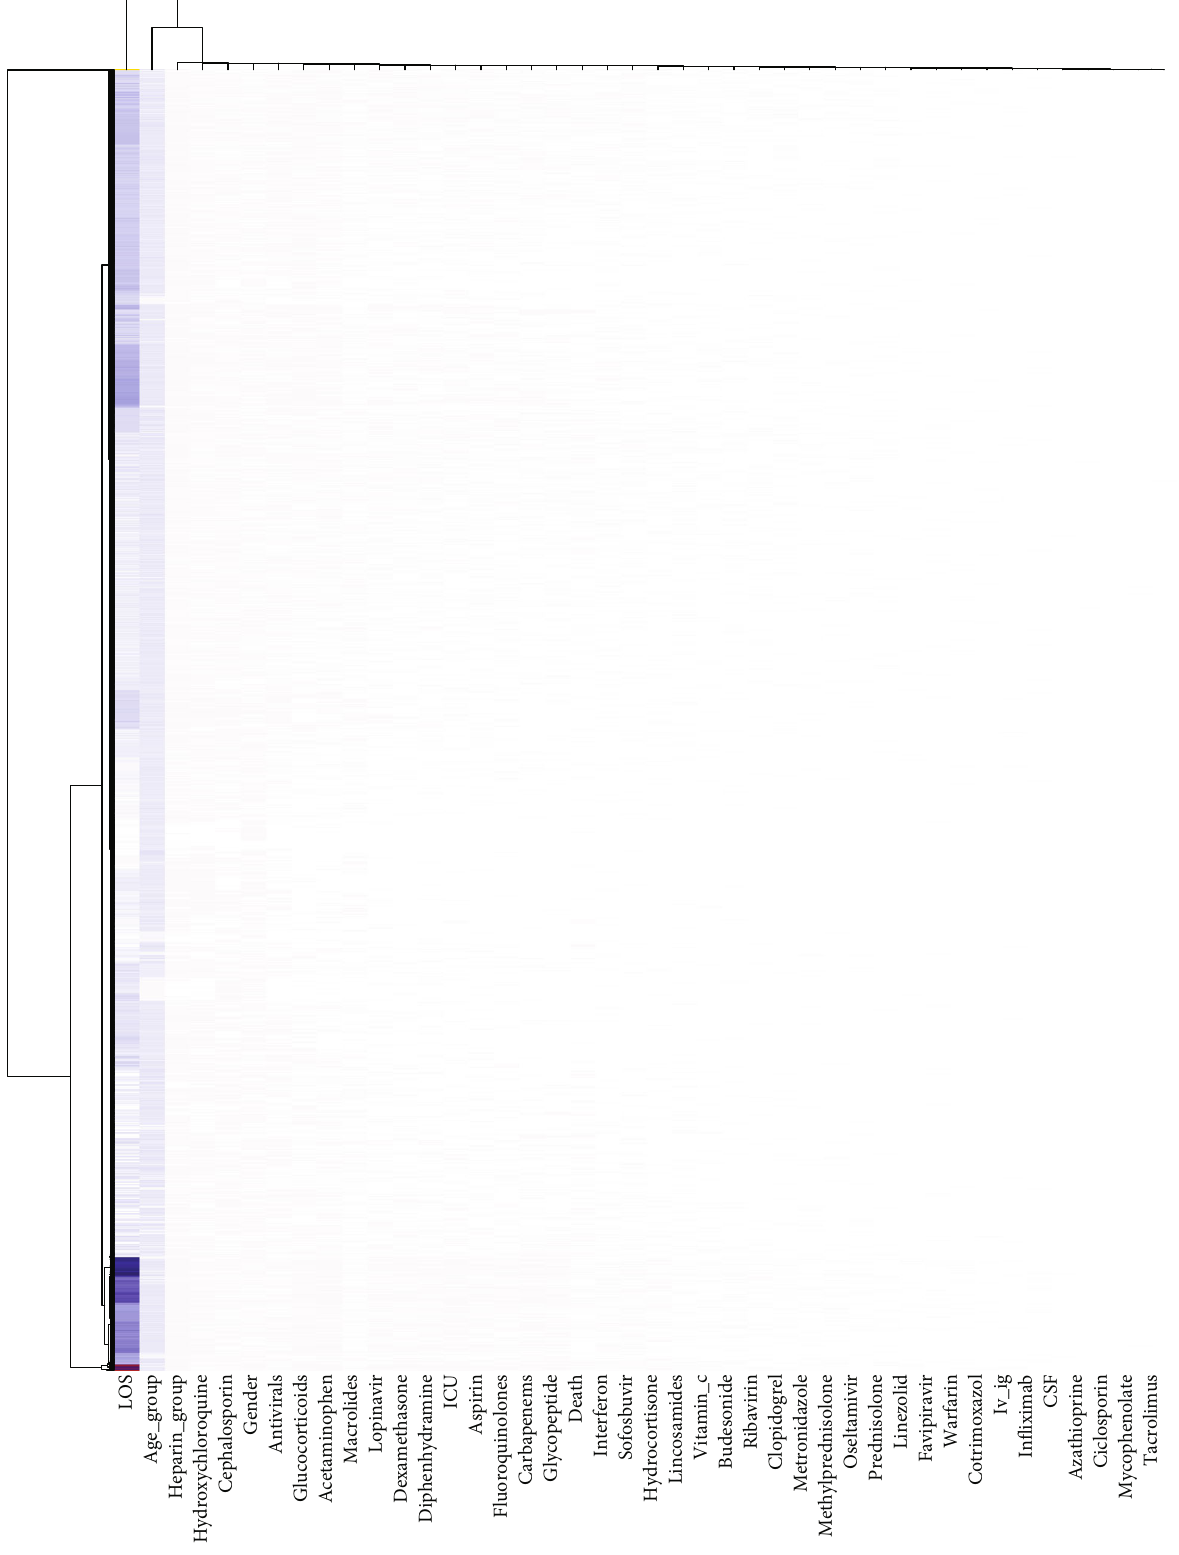
Figure 3: Data clustering level of our data mining study (for age group, the groups are 0-15, 16-30, 31-50, 51-80, and >